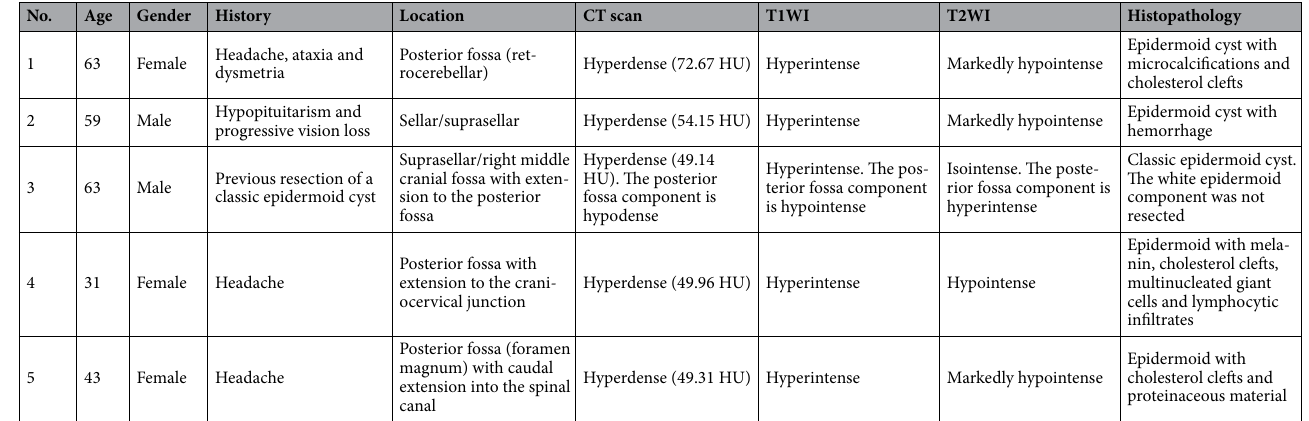
Table 1. Patient demographics, clinical presentation, lesion imaging features and histopathological